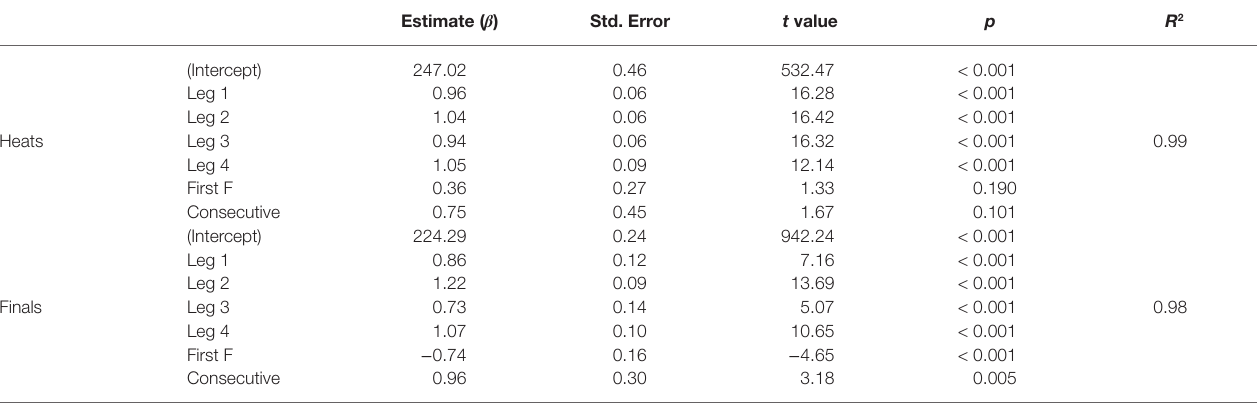
TABLE 2 | Linear regression models for the 4 × 100 m mixed medley relay events during 2015, 2017, and 2019 editions of 50 m World Swimming Championships. Estimate ( β ) Std. Error t value